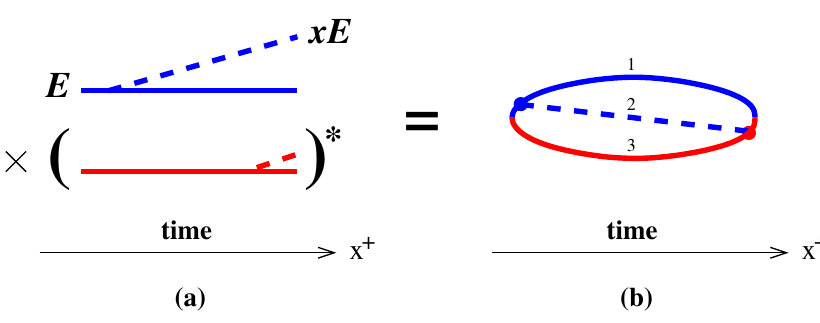
Figure 3 . (a) A time-ordered contribution to the rate for single splitting, such as g → gg of high-energy gluons, with amplitude in blue and conjugate amplitude in red. (b) A single diagram representing this contribution to the rate. In both cases, all lines implicitly interact with the